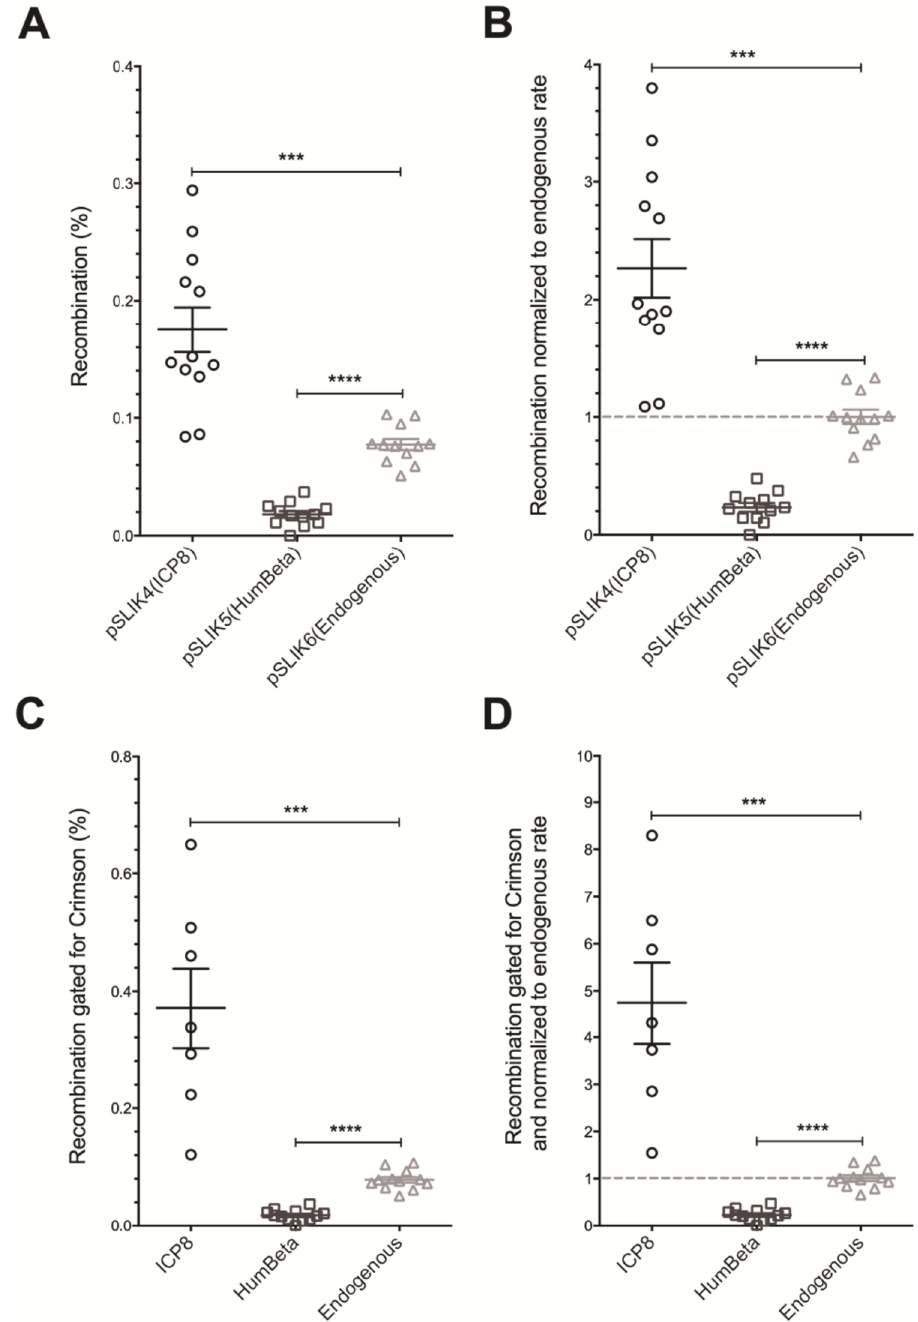
Fig 3. Gene targeting is stimulated by HHV1 ICP8 and inhibited by phage λ Beta in human cells. Cells were incubated with doxycycline to induce synaptase expression and subsequently transfected with 50 nM of oligo 85. A) The background of green cells in “no oligo” control experiments (0.001% for pSLIK4, 0.003% for pSLIK5 and 0.012% for pSLIK6) was subtracted from recombination frequencies. B) Recombination frequencies in (A) were normalized to the mean of the endogenous recombination frequencies in the pSLIK6 control line. C) Cells were gated for Crimson expression (which is expressed in equimolar amounts with the synaptase via translational coupling through a P2A linker) and evaluated as in (A). D) Recombination frequencies in (C) were normalized to the mean of the endogenous recombination frequencies in the pSLIK6 control line and evaluated as in (A). Data were evaluated by Fisher’s Exact Test of significance; (cid:3)(cid:3)(cid:3) indicates P < 0.005 and (cid:3)(cid:3)(cid:3)(cid:3) indicates P < 0.001. The figure shows sample data from one of eight biological replicates, n = 12 trials, and error bars reflect SEM.